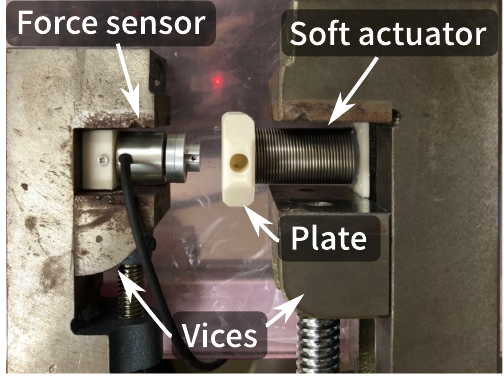
Figure 9. Experiment